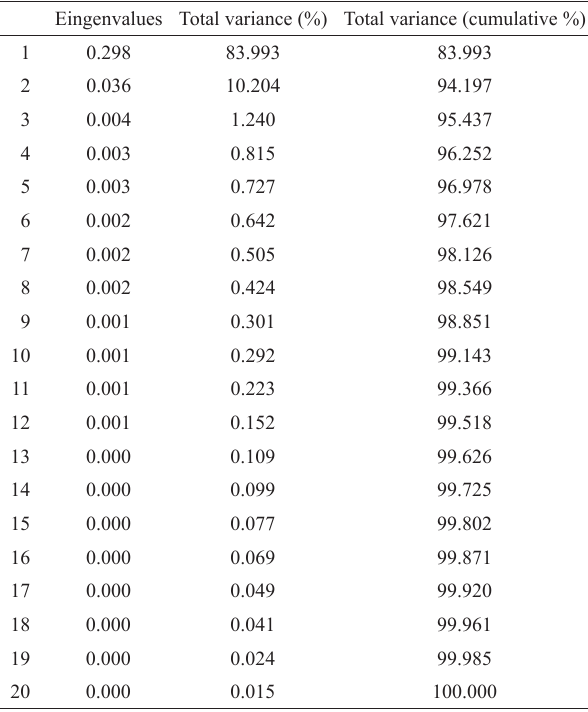
Table 3. Principal component analysis of Rhamdia branneri (n=16) and R. voulezi (n=30). Sheared Principal Component Analysis and Eigenvalues (Prior to Shearing).